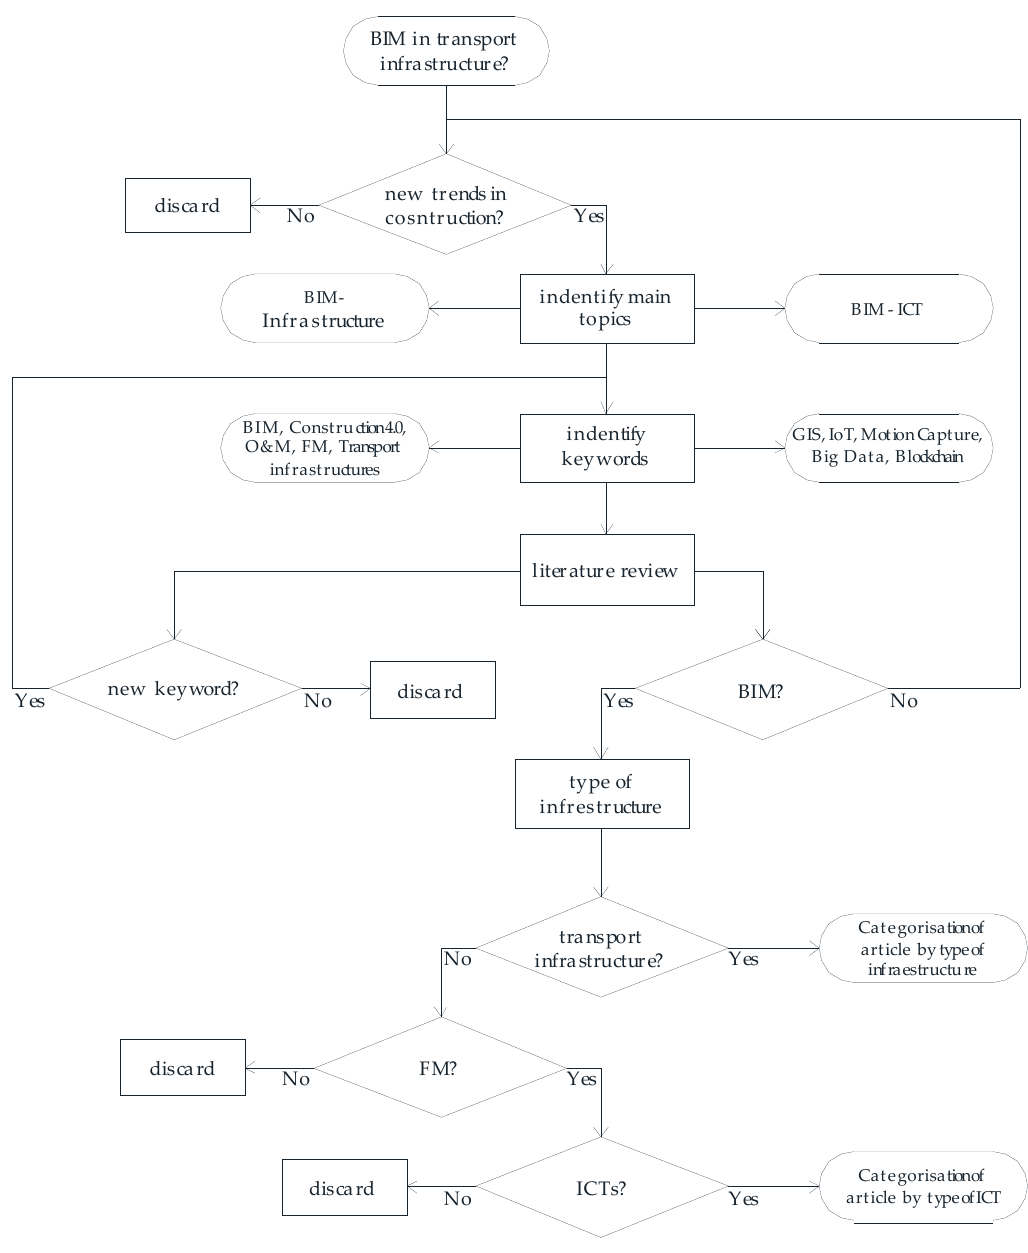
Figure 1. Flowchart used in this state of the art.